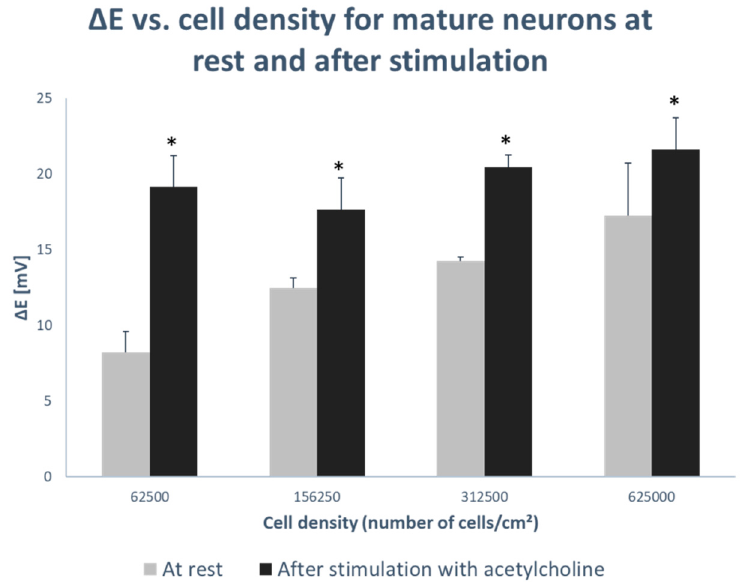
Figure 4. Microplate readings of mature neurons before and after stimulation. Data is presented as the average and standard deviation of three biological replicates. Statistics were performed by one-way paired student t -test. * signifies statistical significance between the After stimulation with acetylcholine readings versus the At rest